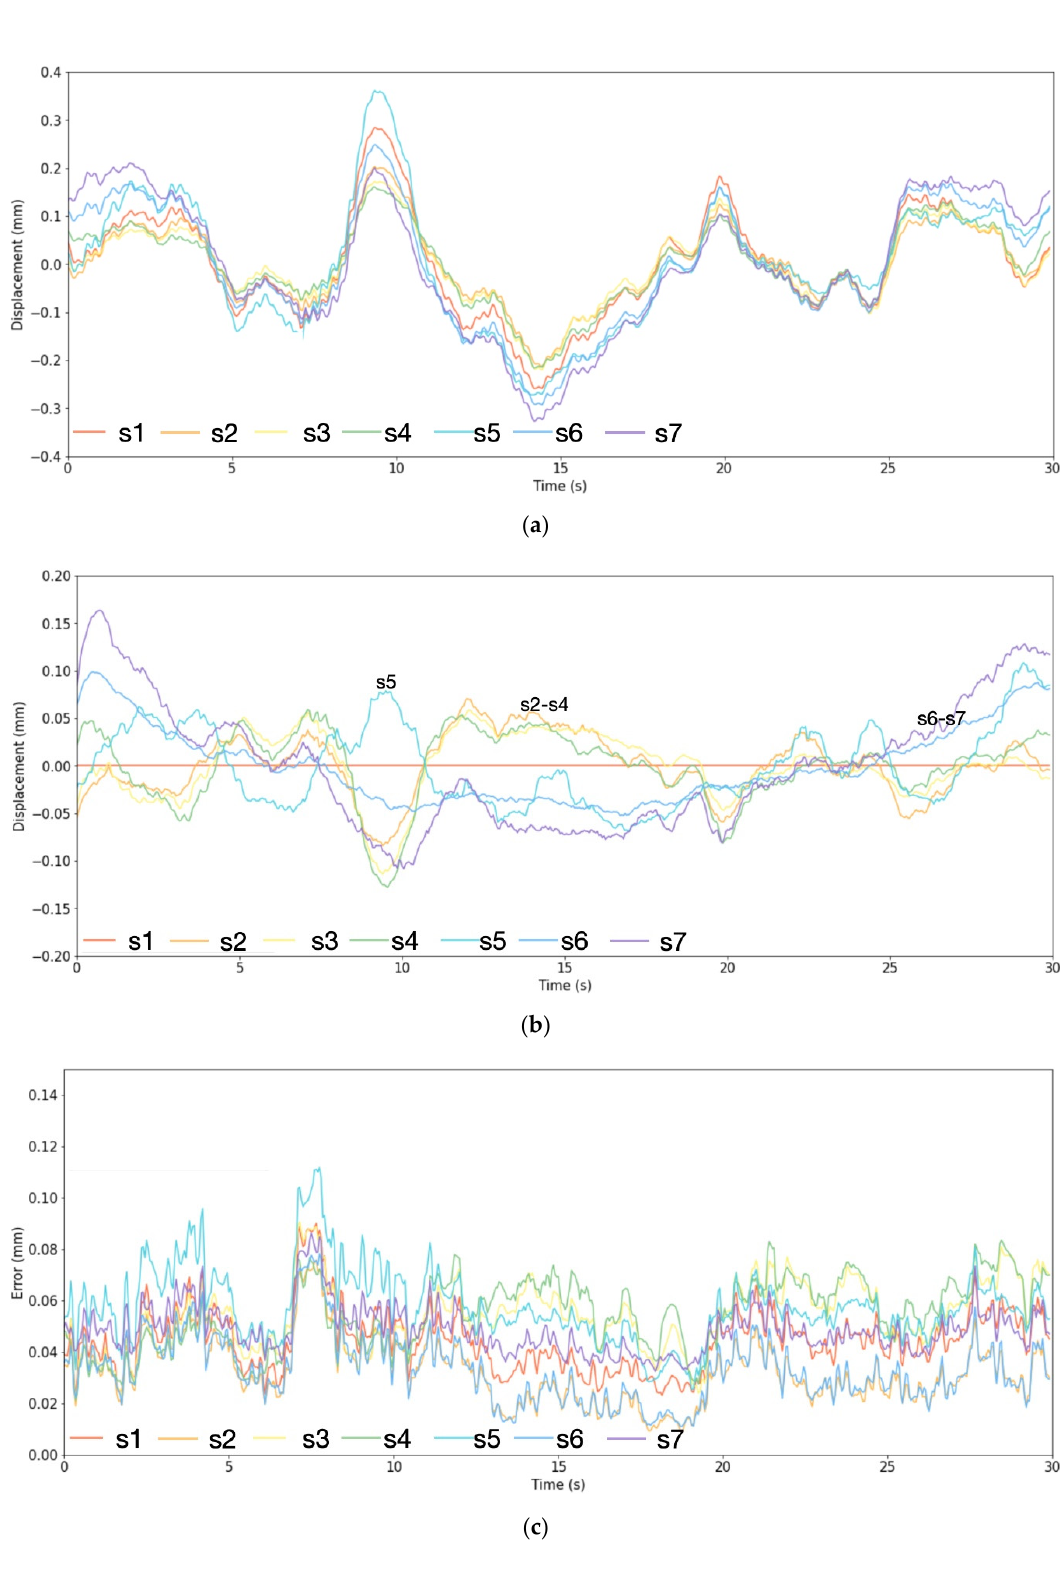
Figure 9. ( a ) Detrended and smoothed horizontal displacement. ( b ) Residual displacement relative to s1 (red line in ( a )). ( c ) Accuracy of displacement based on coherence and assuming 5 independent